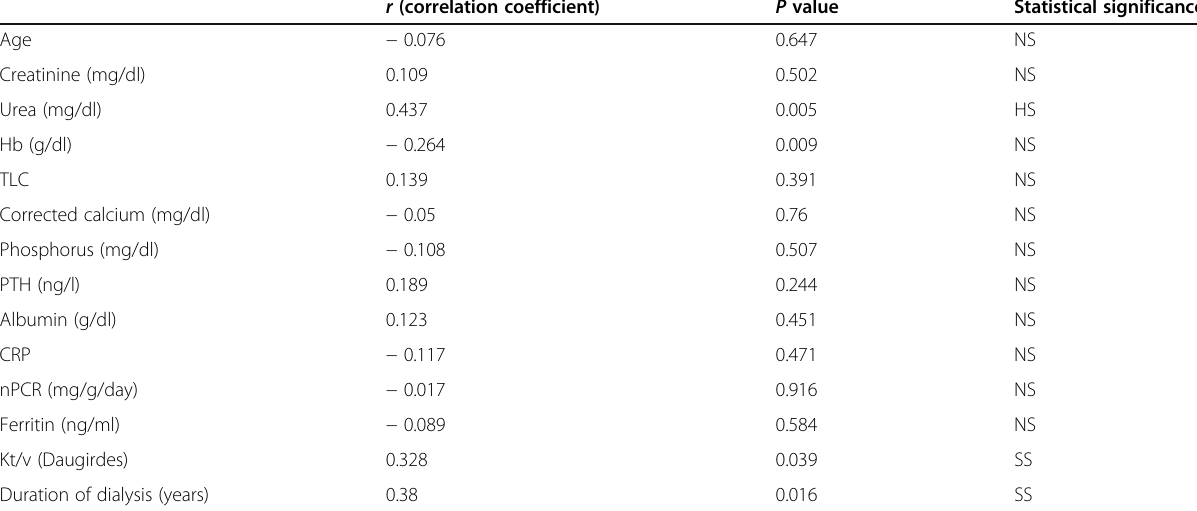
Table 4 The relation between blood lead level and other variables in cases, showing factors associated with high blood lead levels